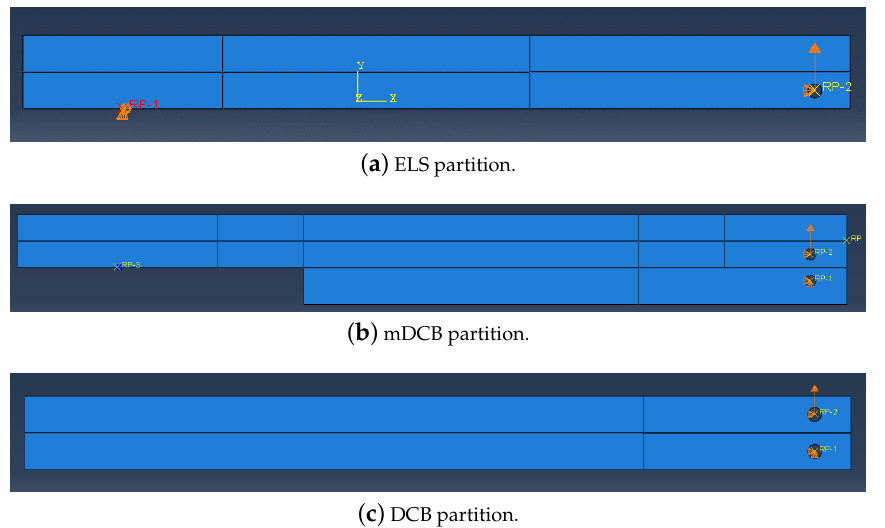
Figure 5. Representative partitions of the specimens used in this numerical study. The boundary conditions are also present in these